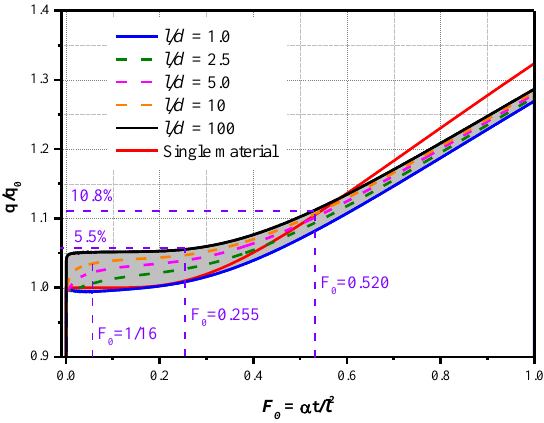
Figure 7. Effects of transverse heat transfer on the calculated heat flux. Figure 7. E ff ects of transverse heat transfer on the calculated heat